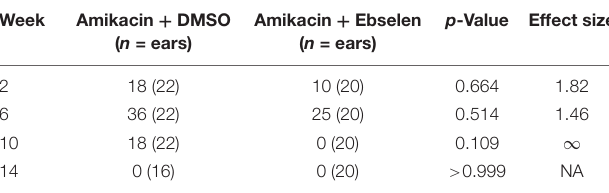
TABLE 1 | Clinically relevant change (CRC) for ABR threshold shifts at 4, 8, 16, and 32 kHz between testing groups 2 and 3.